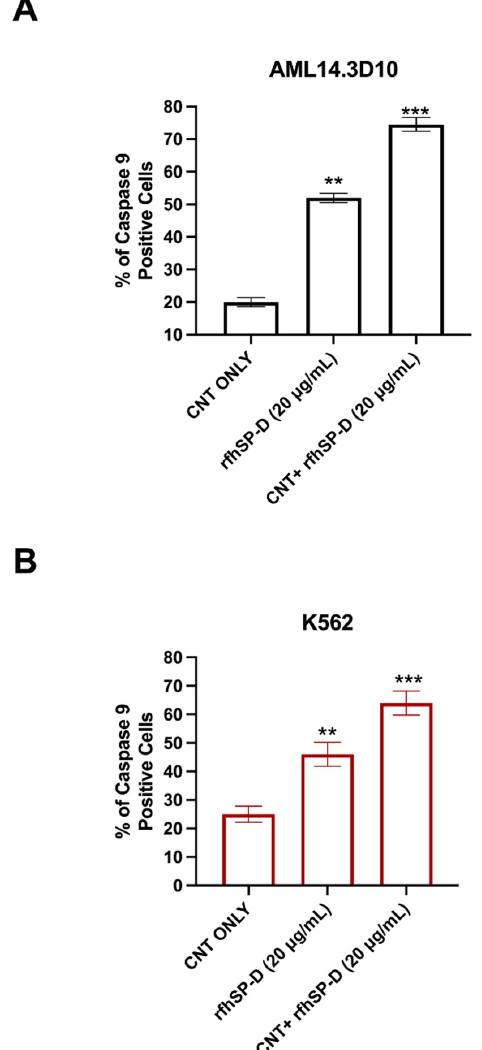
Figure 9. CNT+rfhSP ‐ D treatment upregulates the levels of cleaved caspase 9 on AML14.3D10 ( A ) or K562 ( B ) cell lines at 24 h. AML14.3D10 or K562 cells (0.4 × 10 6 ) were treated with rfhSP ‐ CNT or rfhSP ‐ D, along with an untreated control (cells+CNT). Values are expressed as mean ± SD ( n = 3). ** p < 0.01, and *** p < 0.001 versus control group.